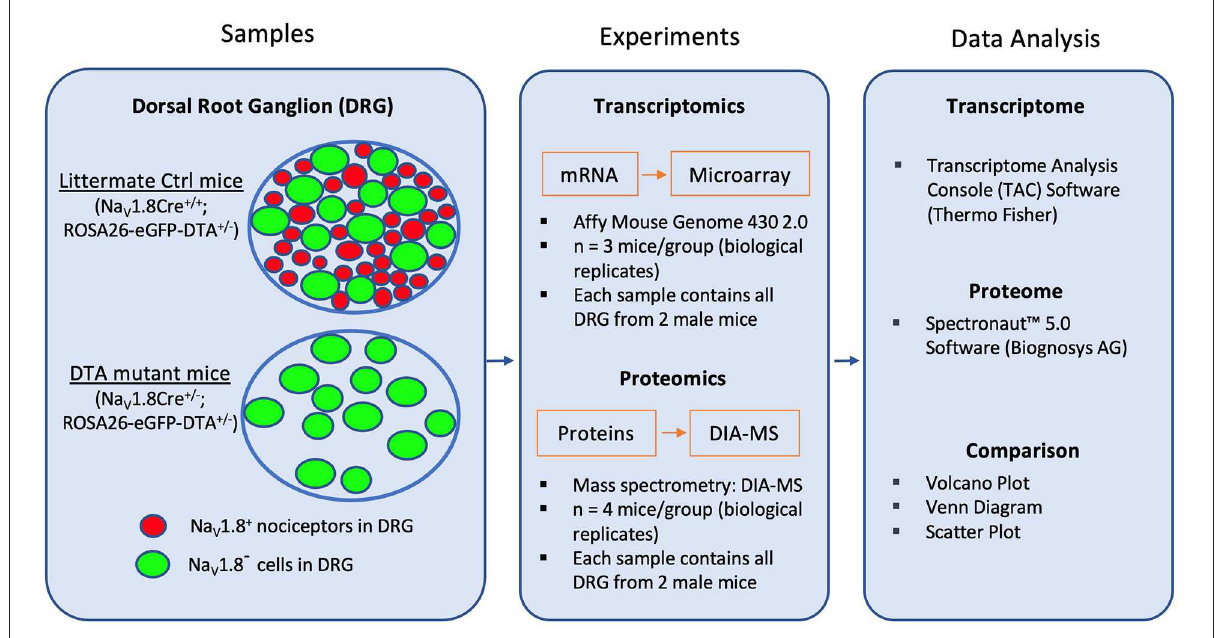
FIGURE1 Schematic diagram for transcriptome and proteome analysis in Na V 1.8-expressing (Na V 1.8 + ) DRG neurons (mainly nociceptors). The diagram shows the key steps of the workflow. First, RNA and protein samples from DRG were collected from both DTA mutant (Na V 1.8Cre + / − ; ROSA26-eGFP-DTA + / − ) mice, in which Na V 1.8 + nociceptors have been ablated, and littermate control (Ctrl) mice (Nav1.8Cre + / + ; ROSA26-eGFP-DTA + / − ). Isolated RNA and proteins were identified with Affymetrix microarray and Data Independent